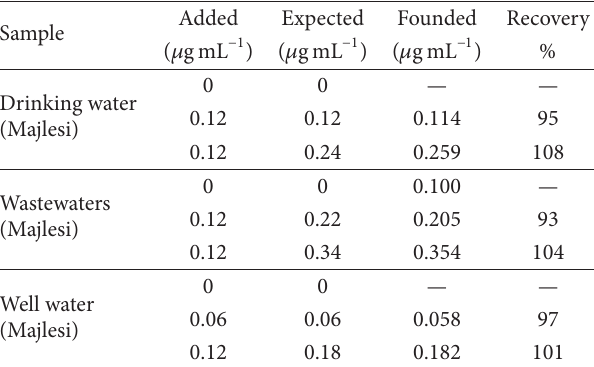
T 2: Determination of thiocyanate in real